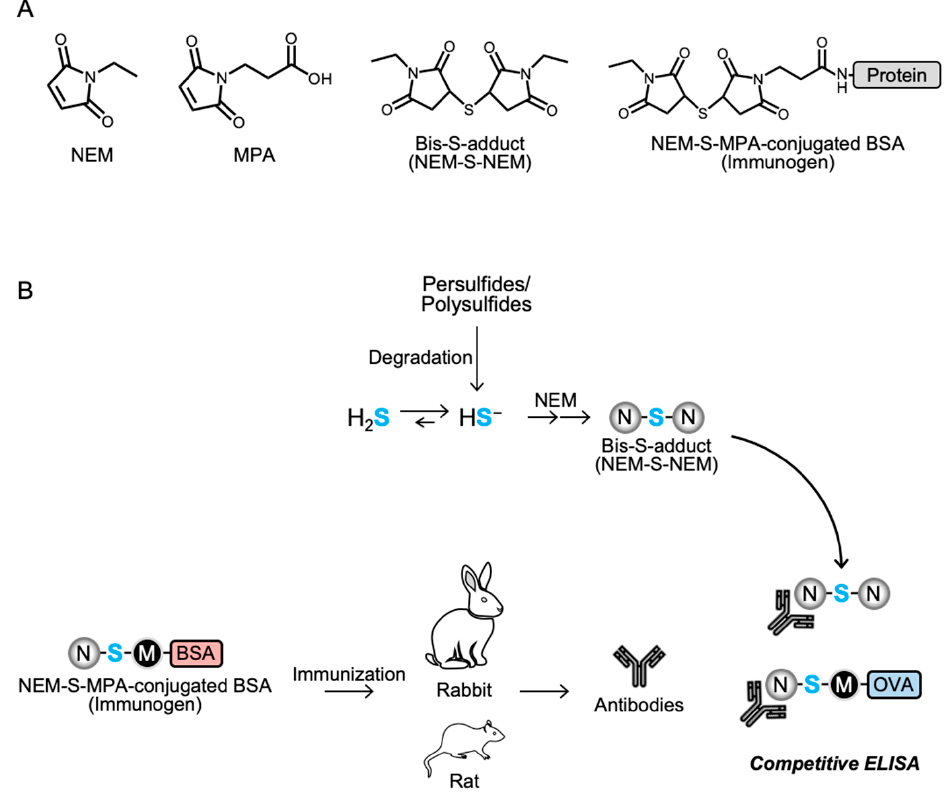
Figure 1. Schematic representation of the reaction of hydrogen sulfide with N -ethylmaleimide. ( A ) Molecular structures of chemicals used in this study. ( B ) H 2 S exists as approximately 20% as the gaseous form (H 2 S), 80% as the deprotonated form (hydrogen sulfide anion, HS − ) in a physiological environment. N -ethylmaleimide (NEM) reacts with HS − to form an intermediate S-adduct, and a subsequent reaction with NEM results in the formation of a stable bis-S-adduct, NEM-S-NEM. NEM-S-NEM can also be formed via decomposition of persulfides / polysulfides. 3- maleimidopropionic acid; BSA, bovine serum albumin; OVA, ovalbumin.